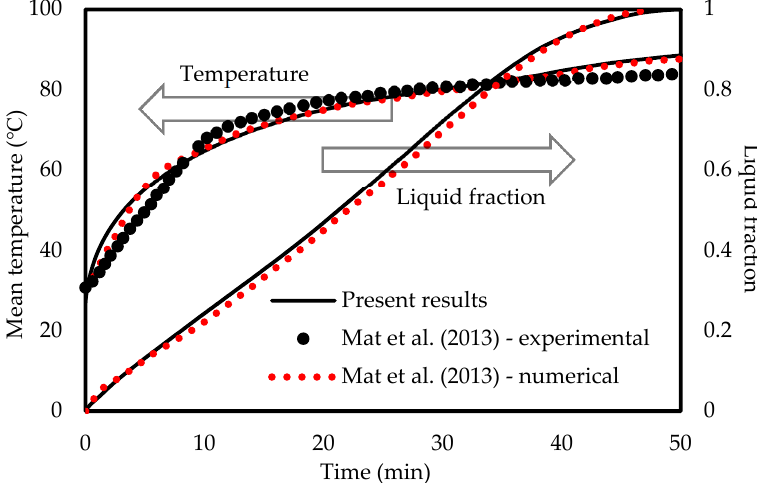
Figure 4. Code verification comparing with the data of Mat et al. [67] .